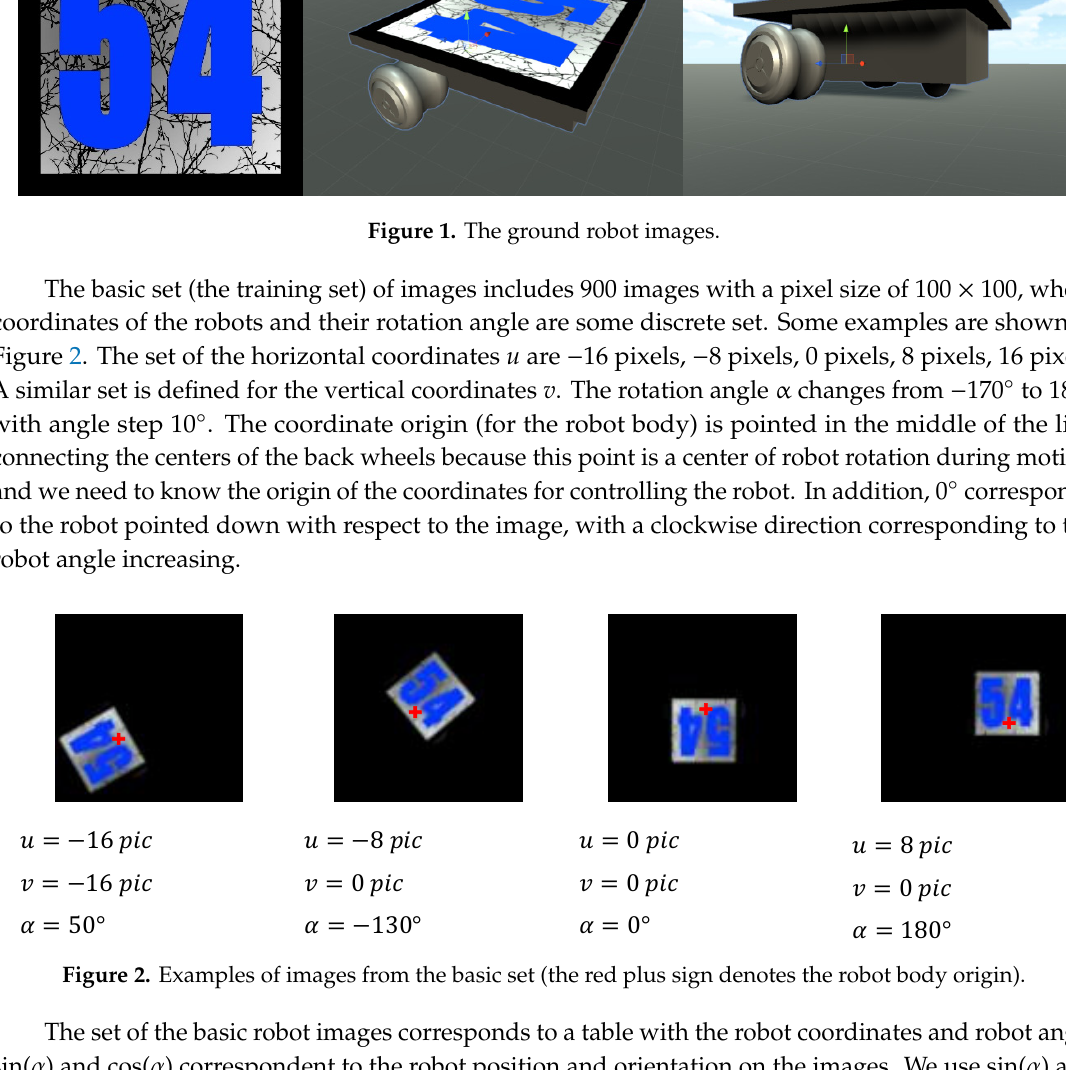
Figure 2. Examples of images from the basic set (the red plus sign denotes the robot body origin).